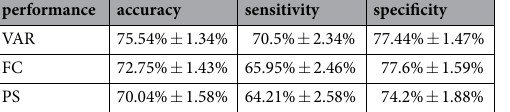
Table 2. Performance of the diagnostic model based on 10-folds CV.